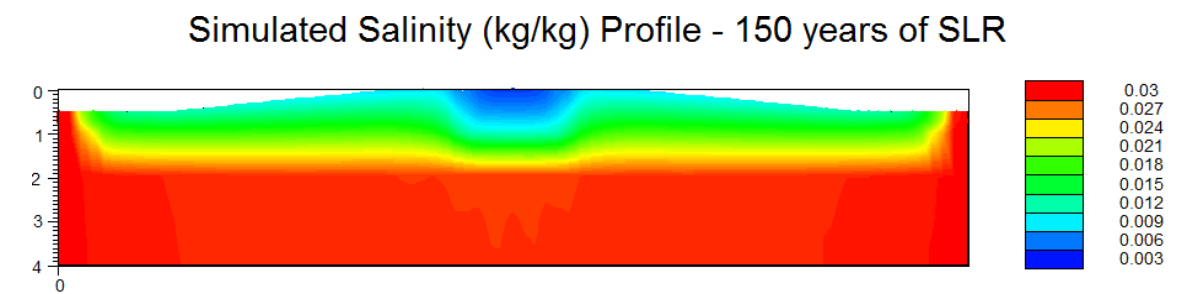
Figure 7. ( Top ) Simulated distribution of mangroves (red) and hardwood hammock (blue) trees along a 400-meter transect across the Coot Bay Hammock after 150 years subject to plausible SLR scenario (3 mm/year). ( Bottom ) Simulated salinity